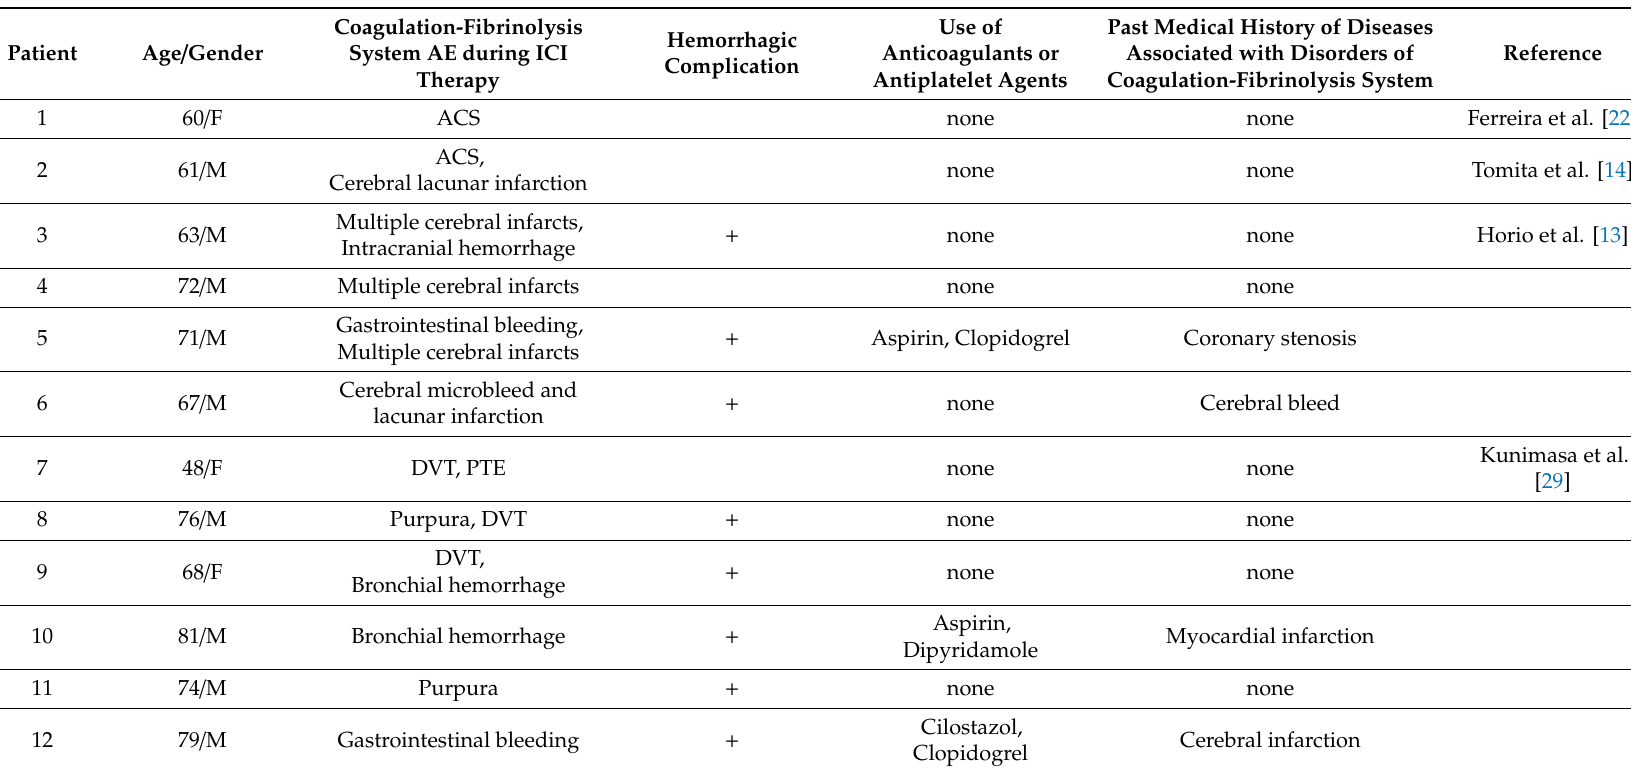
Table 2. Past medical history of NSCLC patients who developed diseases associated with disorders of coagulation-fibrinolysis system during immune checkpoint blockade